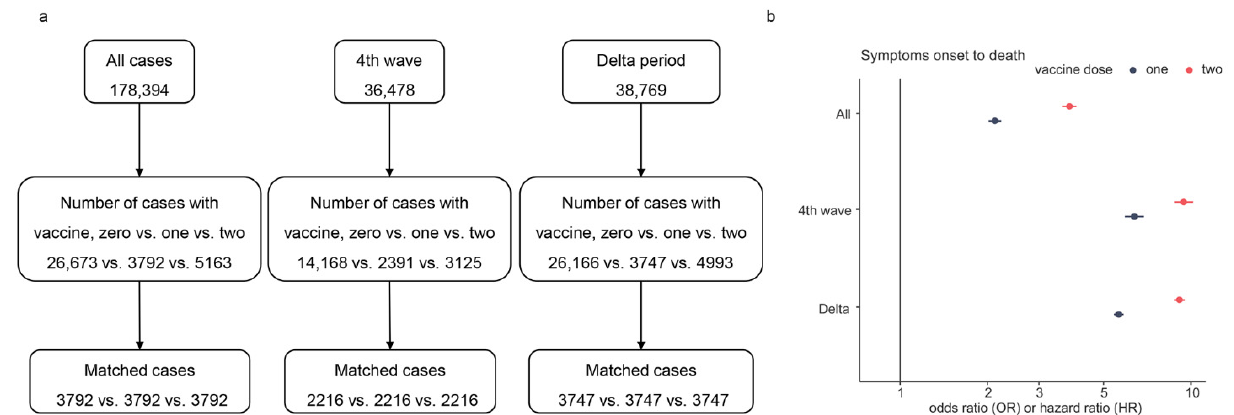
Figure 5. Multiple PSM processes and the odds/hazard ratio of vaccine doses on SOD. Panel ( a ) is the flowchart of multiple PSM for vaccine doses, and panel ( b ) shows the estimated OR/HR values of vaccine doses, where only the ratio of the fourth wave is HR and others are OR.